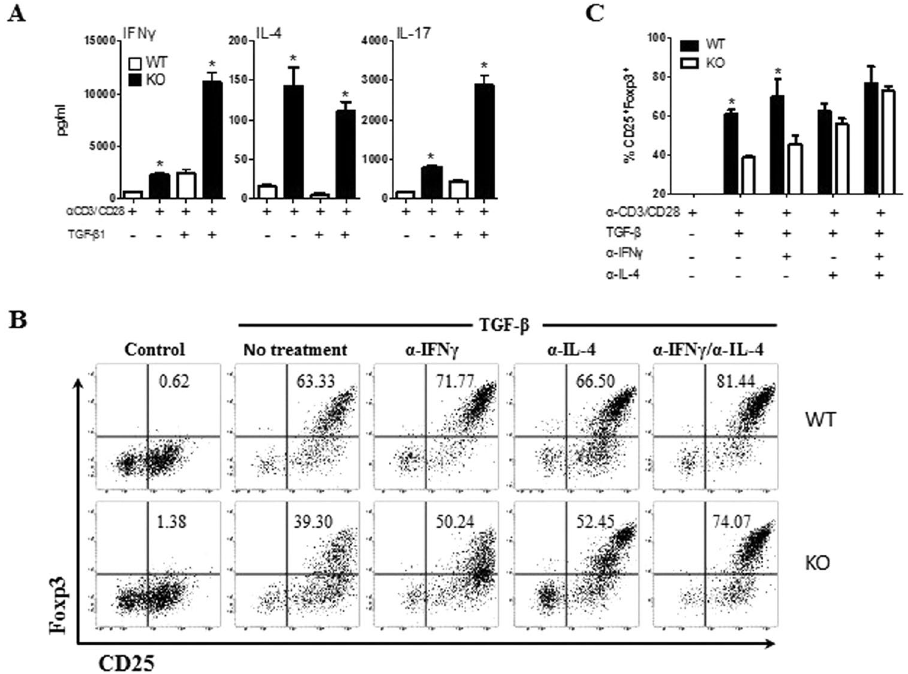
Figure 3. Effect of the cytokine milieu on the PD-1H-mediated defects on the conversion of iTreg cells. ( A ) Cytokine profile in the induction of iTreg cells in the absence of PD-1H. Naïve T cells were induced to iTreg in vitro as described above and the cultured supernatants were collected at day 4 to determine cytokine levels by mouse Th1/TH2/Th17 CBA kits. ( B ) Neutralizing mAb to IFN- γ and IL4 were added to the culture at the beginning of the culture to induce iTreg cells from WT or PD-1H KO naïve T cells in vitro . CD25 + Foxp3 + cells were assessed 3–5 days after the culture. The presented results were from a pair of mice. ( C ) Histogram presentation of the data from ( B ) are from a group of 5 mice. Data shown are representative of at least 3 independent